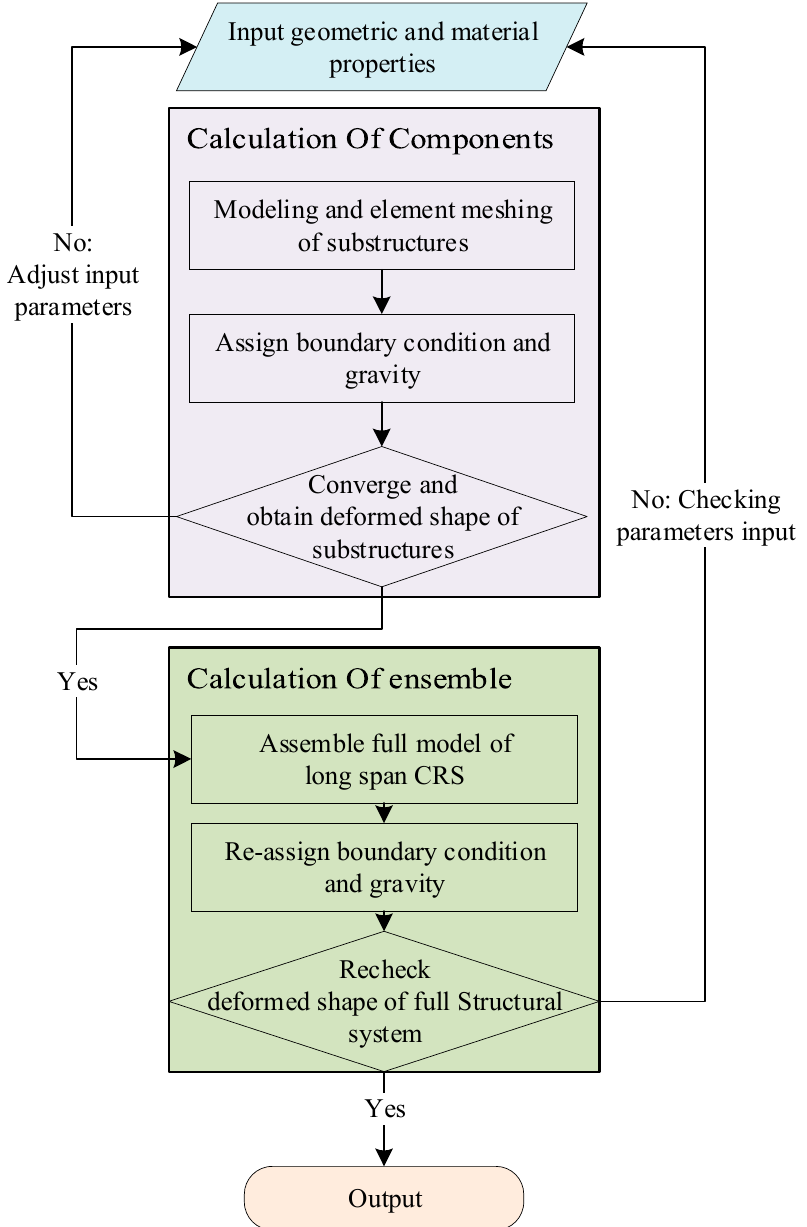
Figure 3. Process of assembly modeling for long-span CRS.